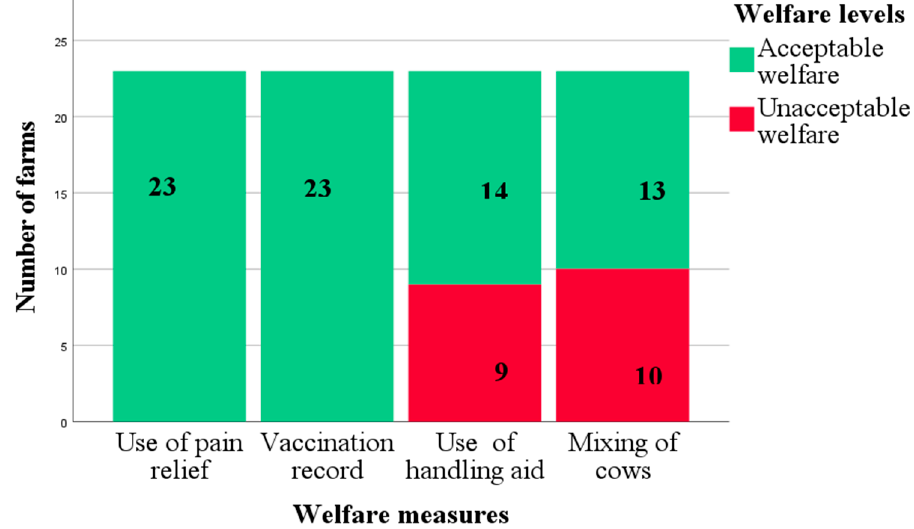
Figure 4. Stacked bar chart for welfare levels of management data for 23 pasture-based dairy farms.